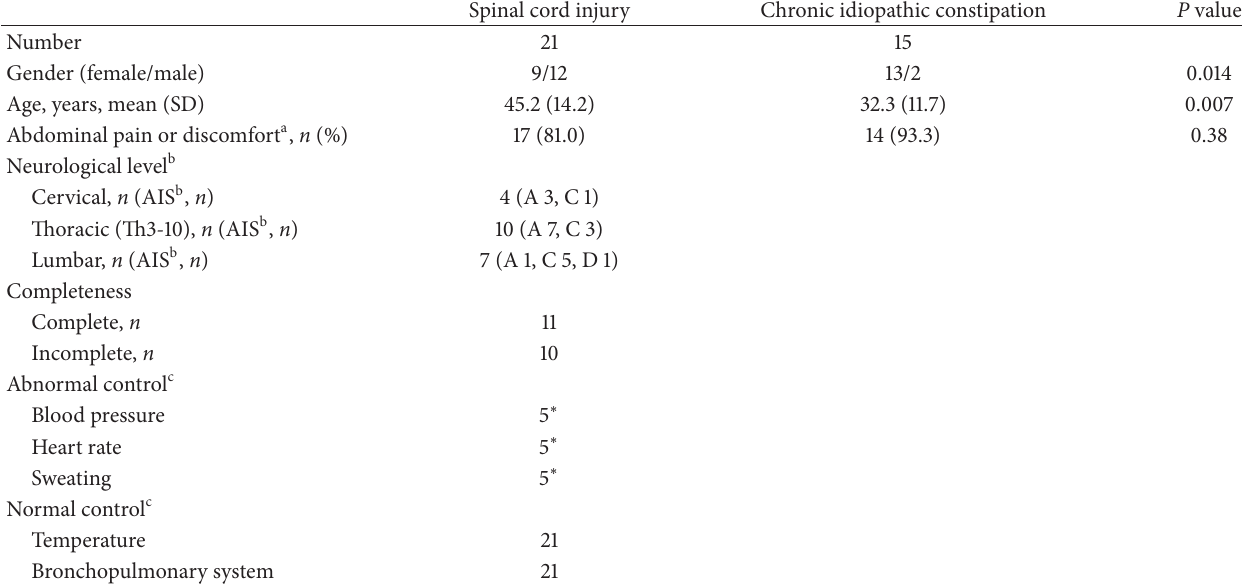
Table 1: Patient characteristics.